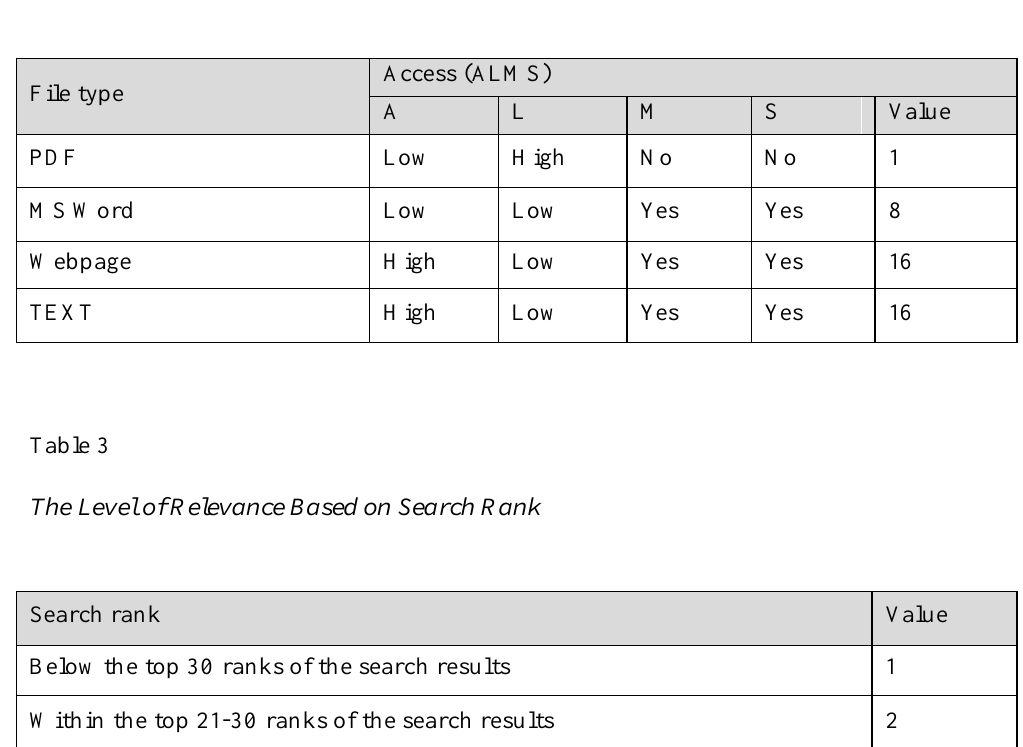
Accessibility Based on the File Type (Abeywardena, Raviraja, & Tham, 2012)